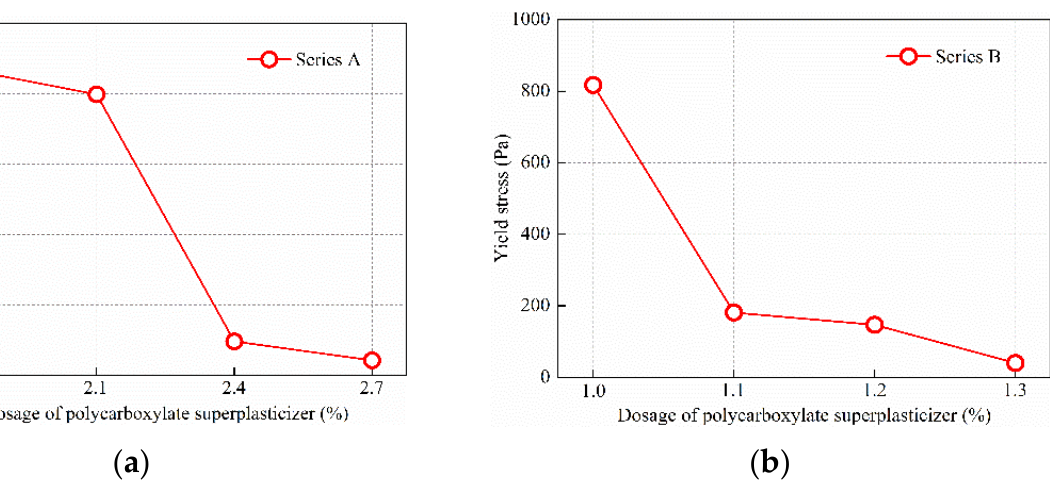
Figure 8. ( a ) Influence of polycarboxylate superplasticizer dosage on yield stress of series A UHPC. ( b ) Influence of polycarboxylate superplasticizer dosage on yield stress of series B UHPC.